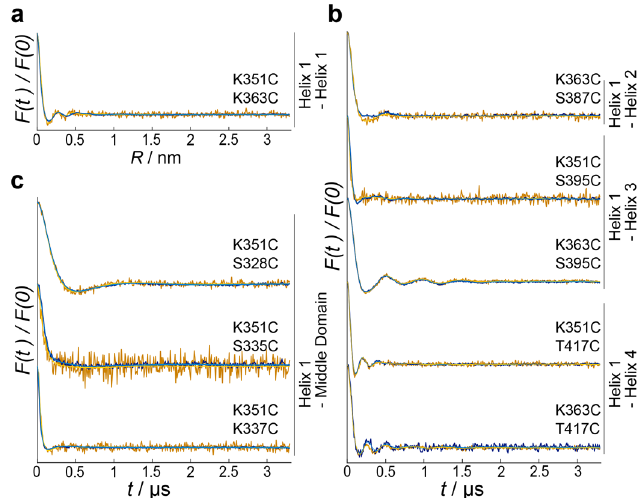
Figure 4. DEER form factors do not differ for RAC with and w/o ribosomes. Similar experimental form factors F ( t ) = V ( t )/ B ( t ) light colors) and corresponding Tikhonov regularization fits (dark colors) of Proxyl-labeled RAC variants in solution (blue) or complexed with ribosomes (yellow) indicate that RAC preserves its conformation upon ribosome binding. RAC was labeled at ( a ) two sites within helix 1 of Zuo1’s 4HB, ( b ) one site in helix 1 and a second site in helix 2–4, or ( c ) one site in helix 1 and a second site in the middle domain. Related DEER raw data is shown in Supplementary Fig.